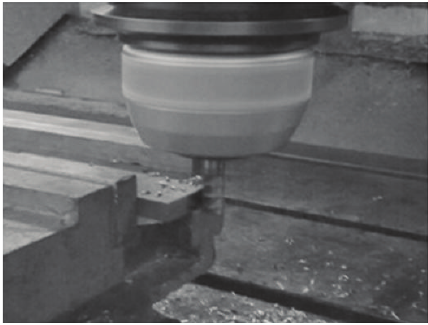
Figure 1: Cutting experiment process.